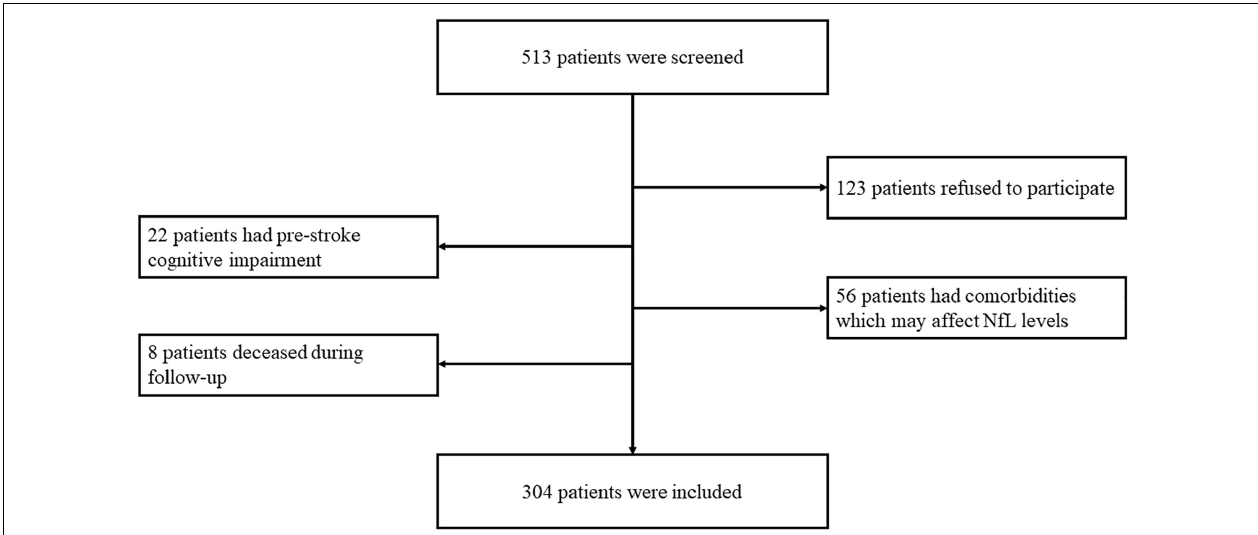
FIGURE 1 | Eligibility and follow-up of patients. In total, 513 patients were screened for eligibility for participation. A total of 123 patients refused to participate, 22 patients had pre-stroke cognitive impairment, 56 patients had comorbidities which may affect serum NfL concentrations, and eight patients were deceased during follow-up. Therefore, 304 patients finally completed the